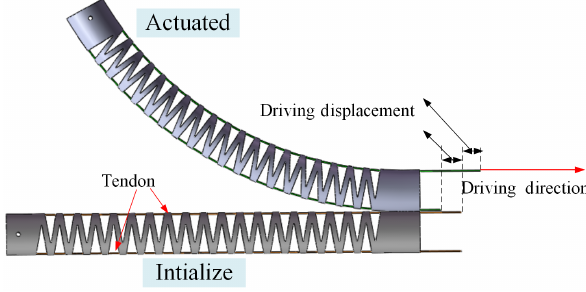
Figure 1. Schematic projection of the notched continuum manipu-